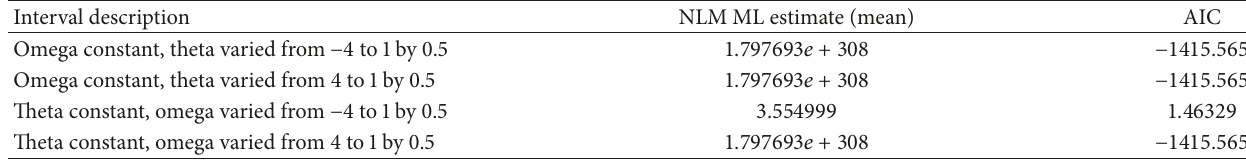
Table 3: Summary of results for lambda = 0.8.